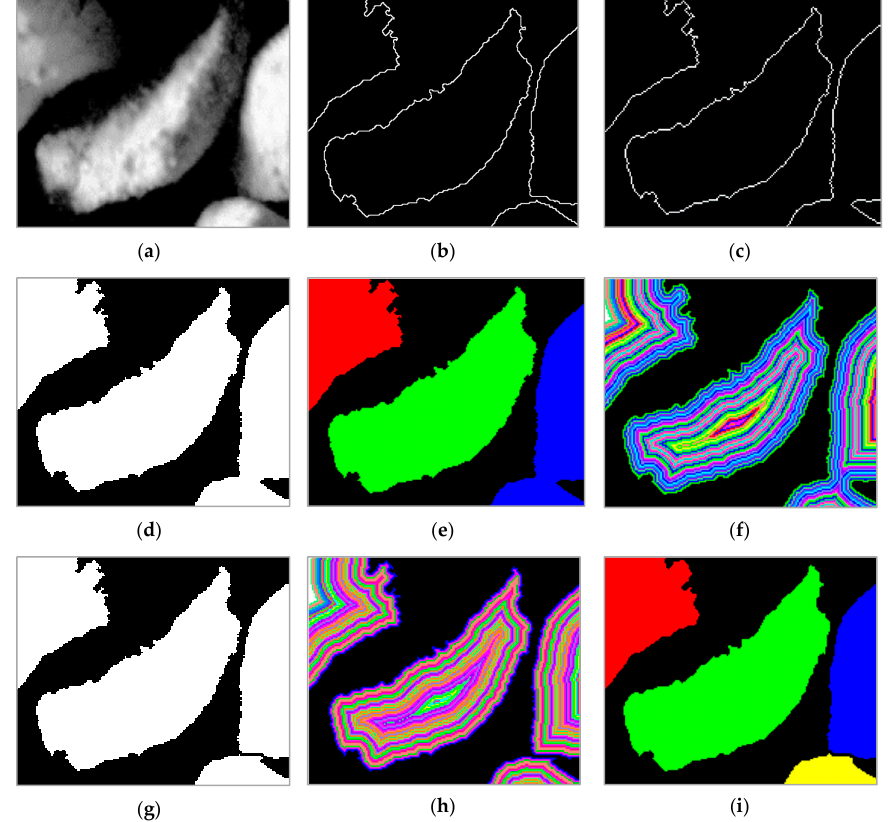
Figure 12. The original zoomed sample image ( a ), grains boundaries detected with the proposed algorithm ( b ), grains boundaries without the proposed modification ( c ), result of segmentation ( d , e ), distance map ( f ), separated grains ( g ), updated distance map ( h ), final segmentation result ( i ).